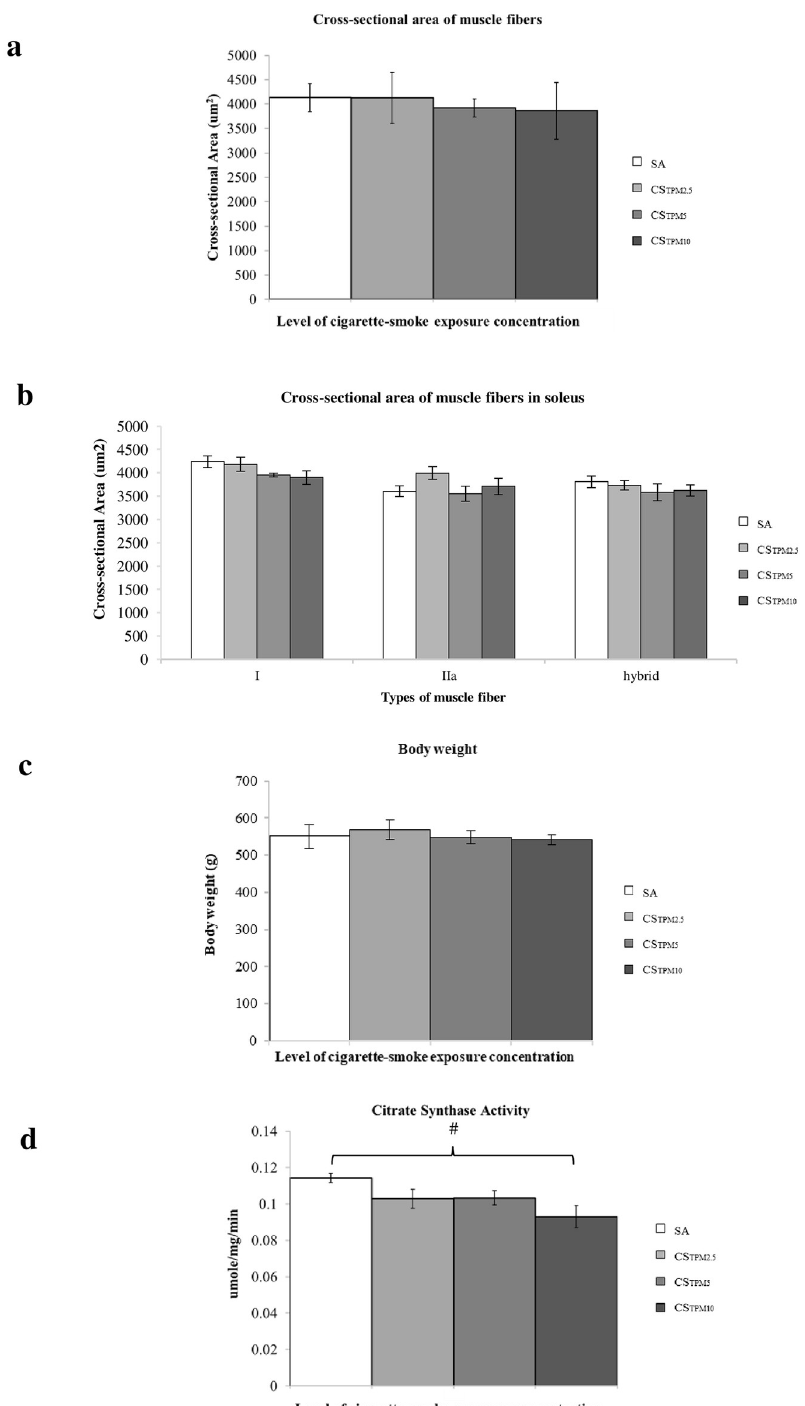
Fig 3. Muscle cross-sectional area, body weight and citrate synthase activity of soleus upon acute cigarette smoke exposure. Histogram summarizing the ( a )) the overall cross-sectional area of soleus muscles, ( b ) the cross-sectional area of individual fiber types, ( c ) the body weight of rats and ( d ) the level of citrate synthase activity of soleus muscles from different SA group and CS groups. Data was presented as mean ± SEM. � indicates p < 0.05 for overall ANOVA comparison; # indicates p < 0.05 in post-hoc